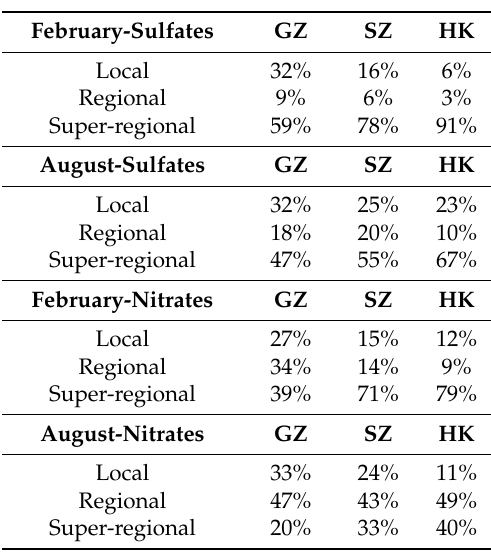
Table 5. Source apportionment of sulfates and nitrates in the city centers of Guangzhou, Shenzhen and Hong